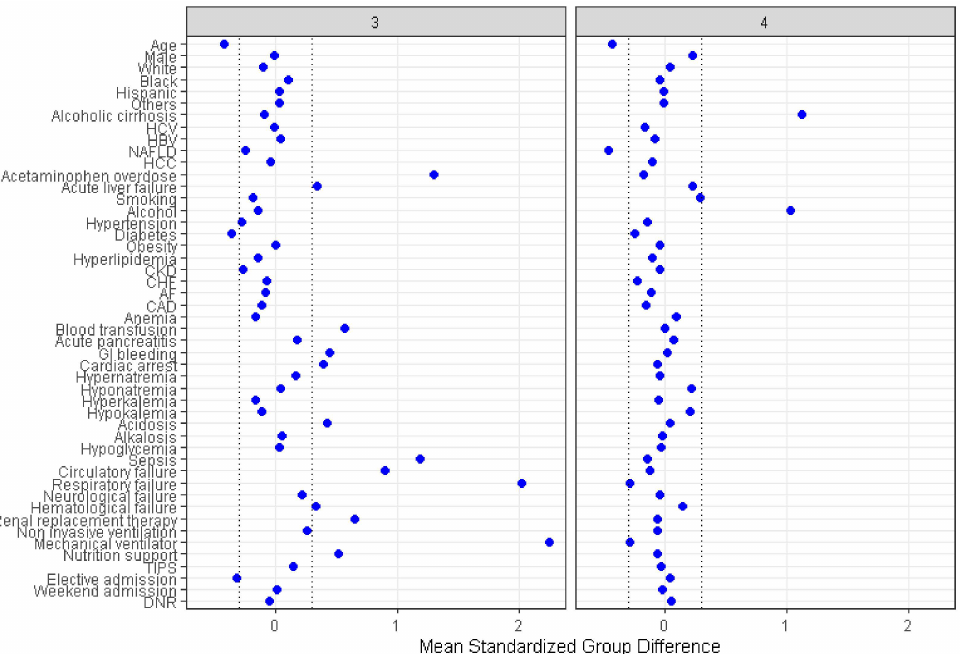
Figure 4. The standardized differences across four clusters for each baseline parameter. AF: Atrial fibrillation, CAD: Coronary artery disease, CKD: Chronic kidney disease, CHF: Chronic heart failure, DNR: Do not resuscitate, HBV: Hepatitis B virus, HCC: Hepatocellular carcinoma, HCV: Hepatitis C virus, NAFLD: Nonalcoholic fatty liver disease, TIPS: Transjugular intrahepatic portosystemic